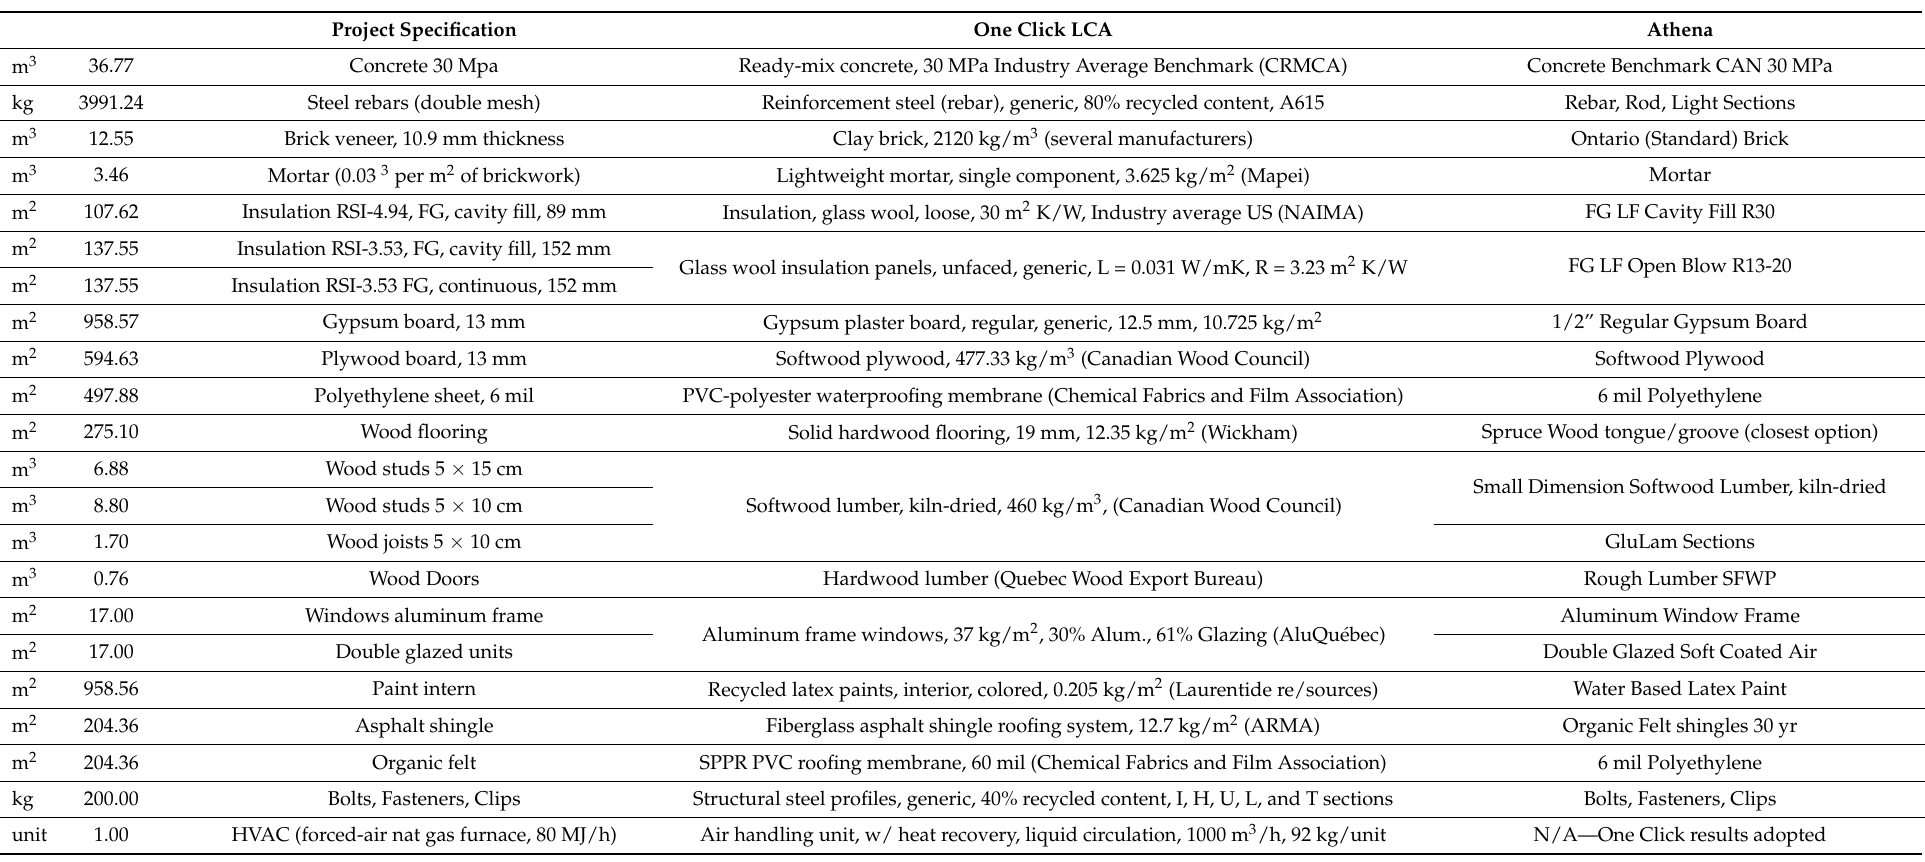
Table 6. Bill of materials according to single-detached house design specs, and correspondent material option chosen in One Click and